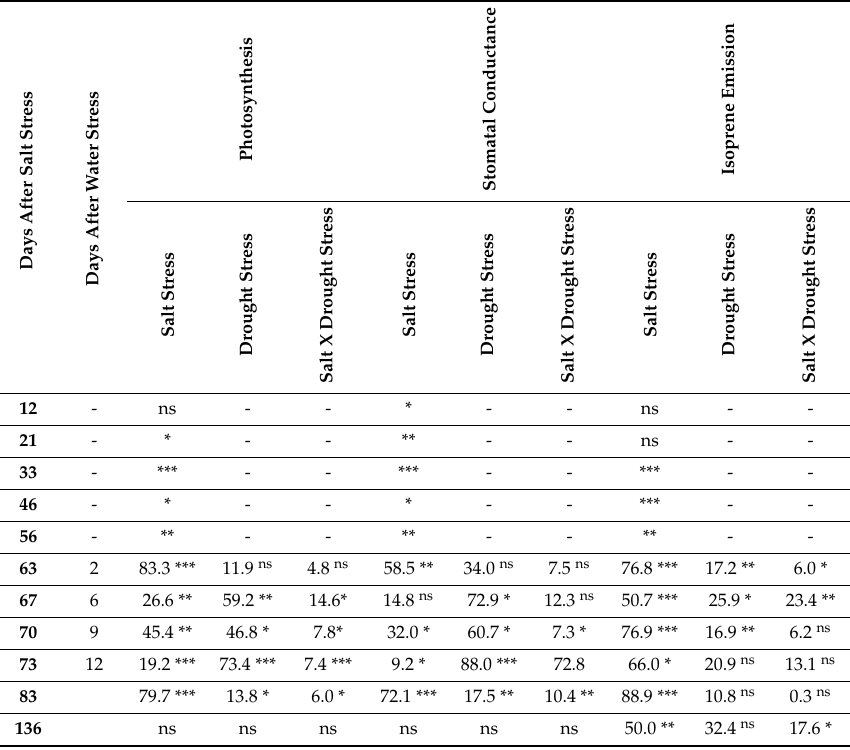
Table 1. Results of linear mixed model analysis of variance, shown as percentage (%) of the variance loaded on fixed factors and interactions, for photosynthesis, stomatal conductance, and isoprene for each day after